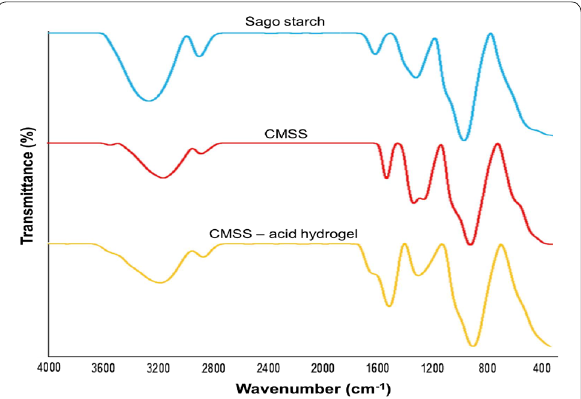
Fig. 8 FT‑IR spectra of sago starch, CMSS and CMSS–acid